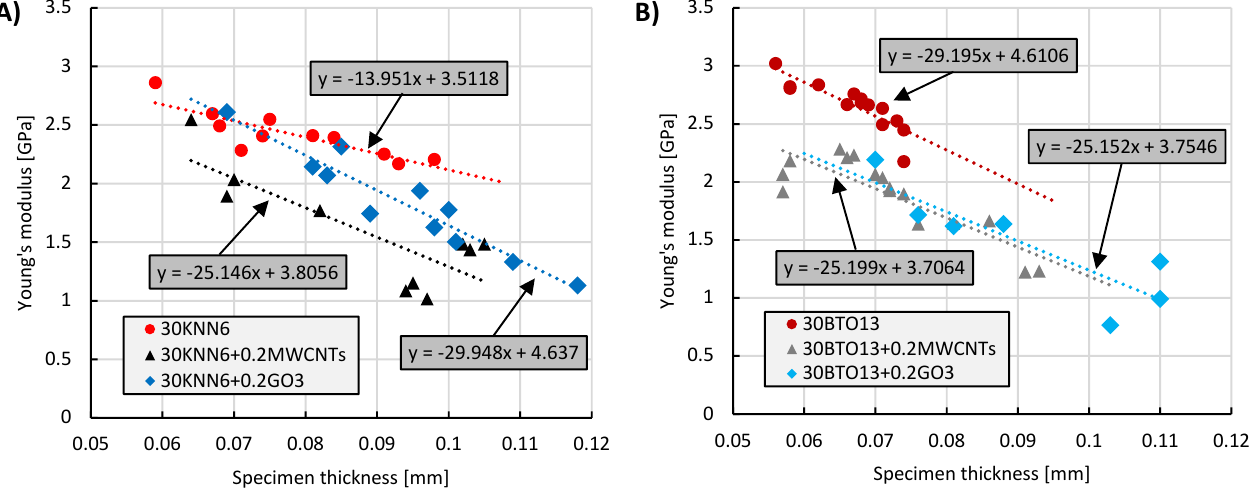
Figure 5. Young’s modulus of solidified piezoelectric composites filled with: ( A ) KNN6 ceramic; ( B ) BTO13